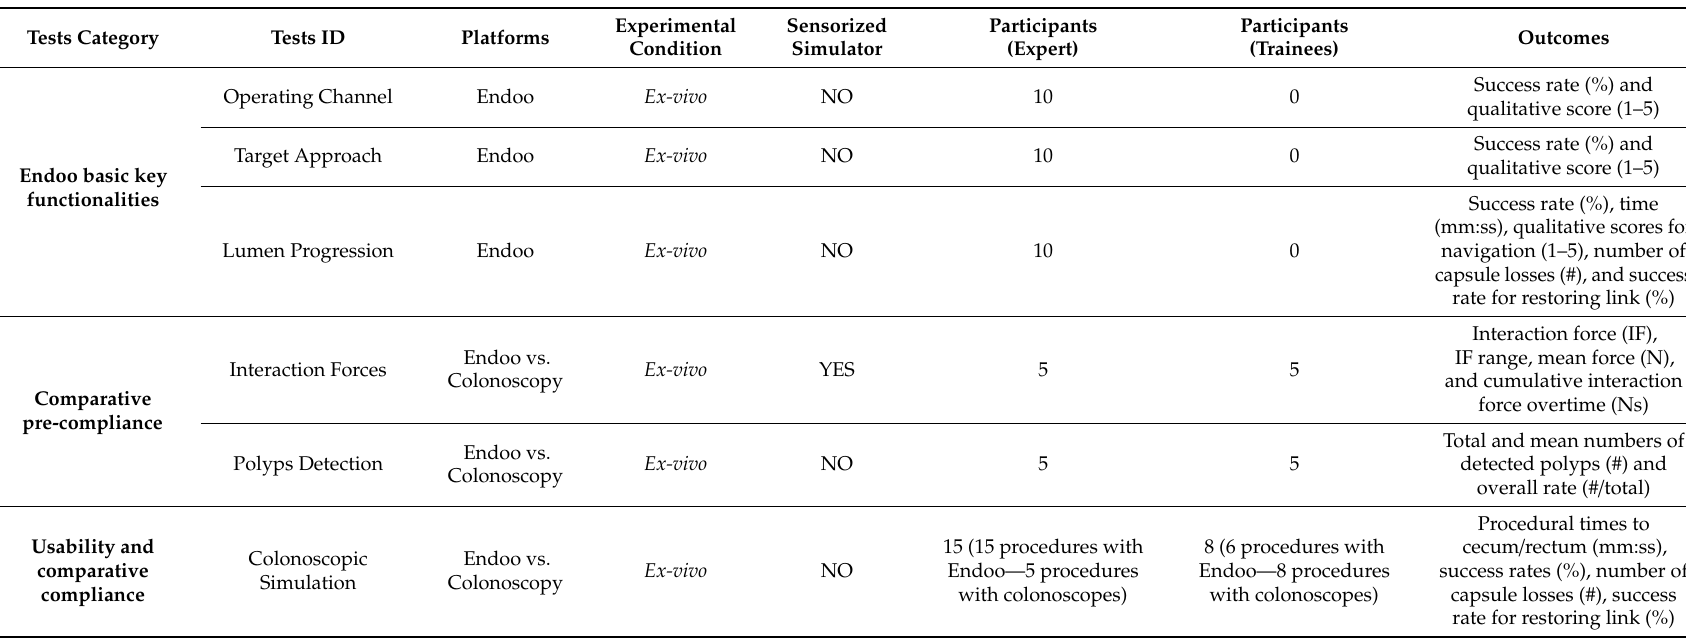
Table 1. Tests Used to Evaluate the Endoo System Functionality, Pre-Compliance, Usability, and Compliance in Comparison with